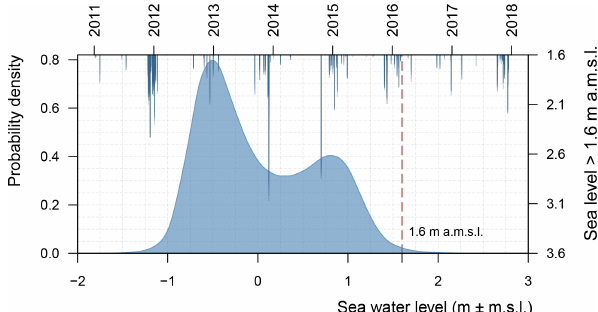
Figure 7. Bimodal probability density curve of sea water levels (in m ± m.s.l.) measured by a buoy near Scheveningen since the con- struction of the Zandmotor in 2011 until 2017. Included are the in- stances when sea water level exceeded the 1.6ma.m.s.l. boundary height for dune development along the Delfland